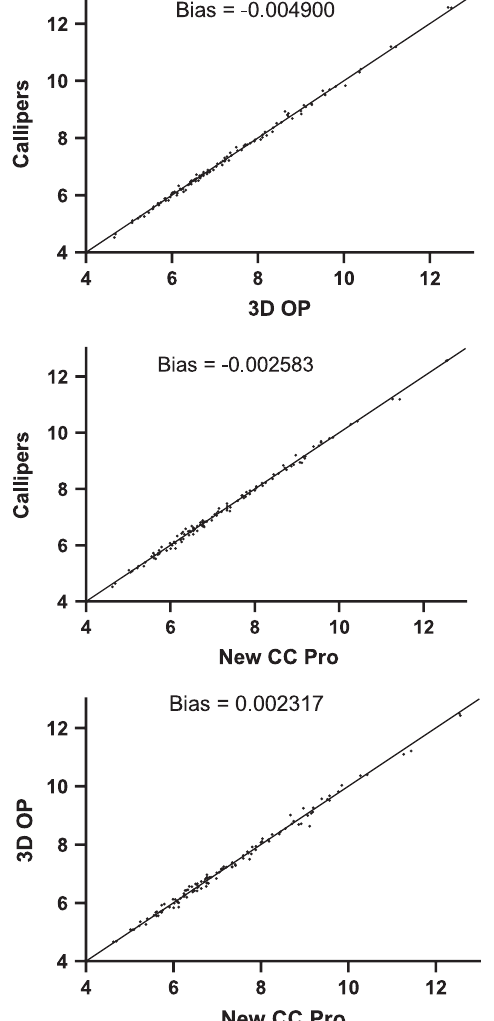
Figure 2. Bland-Altman charts showing levels of agreement between New CC Pro, callipers, and 3D OP.